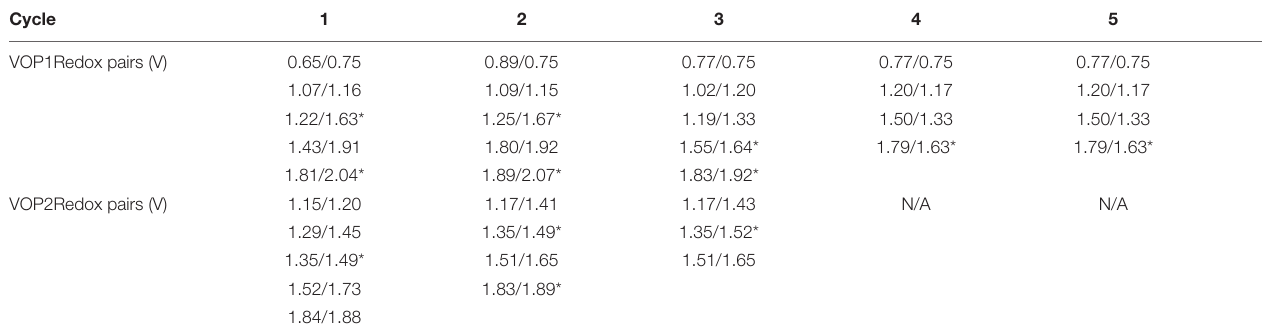
TABLE 1 | Summarized redox pairs of VOP1 in 5 cycles and VOP2 in 3 cycles.